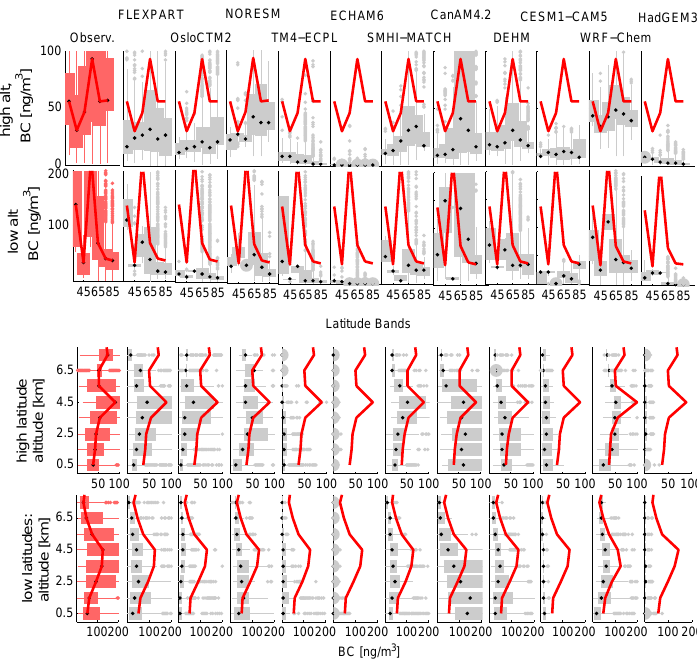
Figure 7. Comparison of modeled BC with observed rBC (red boxes and red lines) mass concentrations from the ARCTAS-spring and ARCPAC campaigns in spring 2008. The leftmost column shows box and whisker plots (like in Fig. 4: boxes go from the 25th to 75th percentiles, whiskers span the 1.5-fold interquartile range) of observed rBC concentrations in ngm − 3 . The black dots as well as the red lines represent the median values. The other columns show the modeled BC concentrations for FLEXPART, OsloCTM2, NorESM, TM4- ECPL, ECHAM6-HAM2, SMHI-MATCH, CanAM4.2, DEHM, CESM1-CAM5.2, WRF-Chem and HadGEM3. The top row represents median (r)BC concentrations for altitudes below 3km a.s.l. as a function of latitude by binning the data into 10 ◦ latitude bands. The second row represents median (r)BC concentrations for altitudes above 3kma.s.l. The third (bottom) row shows median (r)BC concentrations for latitudes north of (south of) 70 ◦ N as a function of altitude by binning the data into 1km height